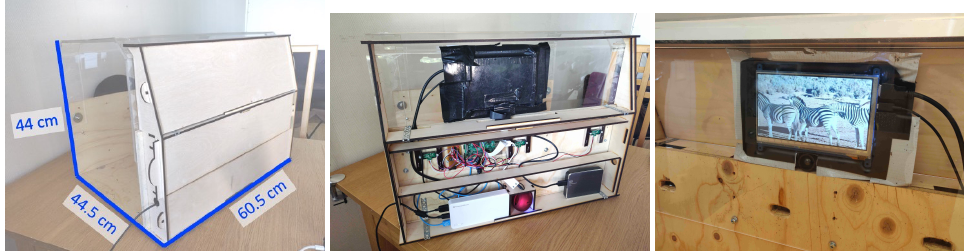
Figure 3. The enrichment device. Left: measurements from the outside, Middle: with the side panel removed to show the technology and screen, Right: view of the screen with the camera below from inside the